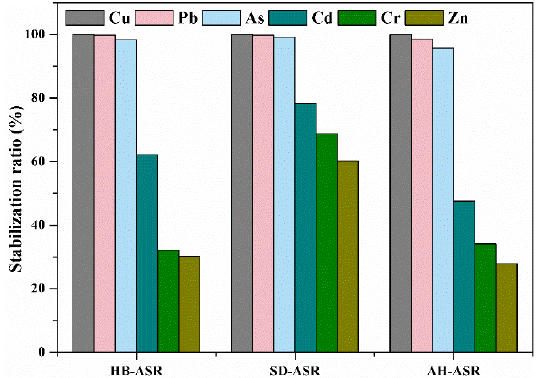
Figure 2. Stabilization ratios of heavy metals for the ASRs.